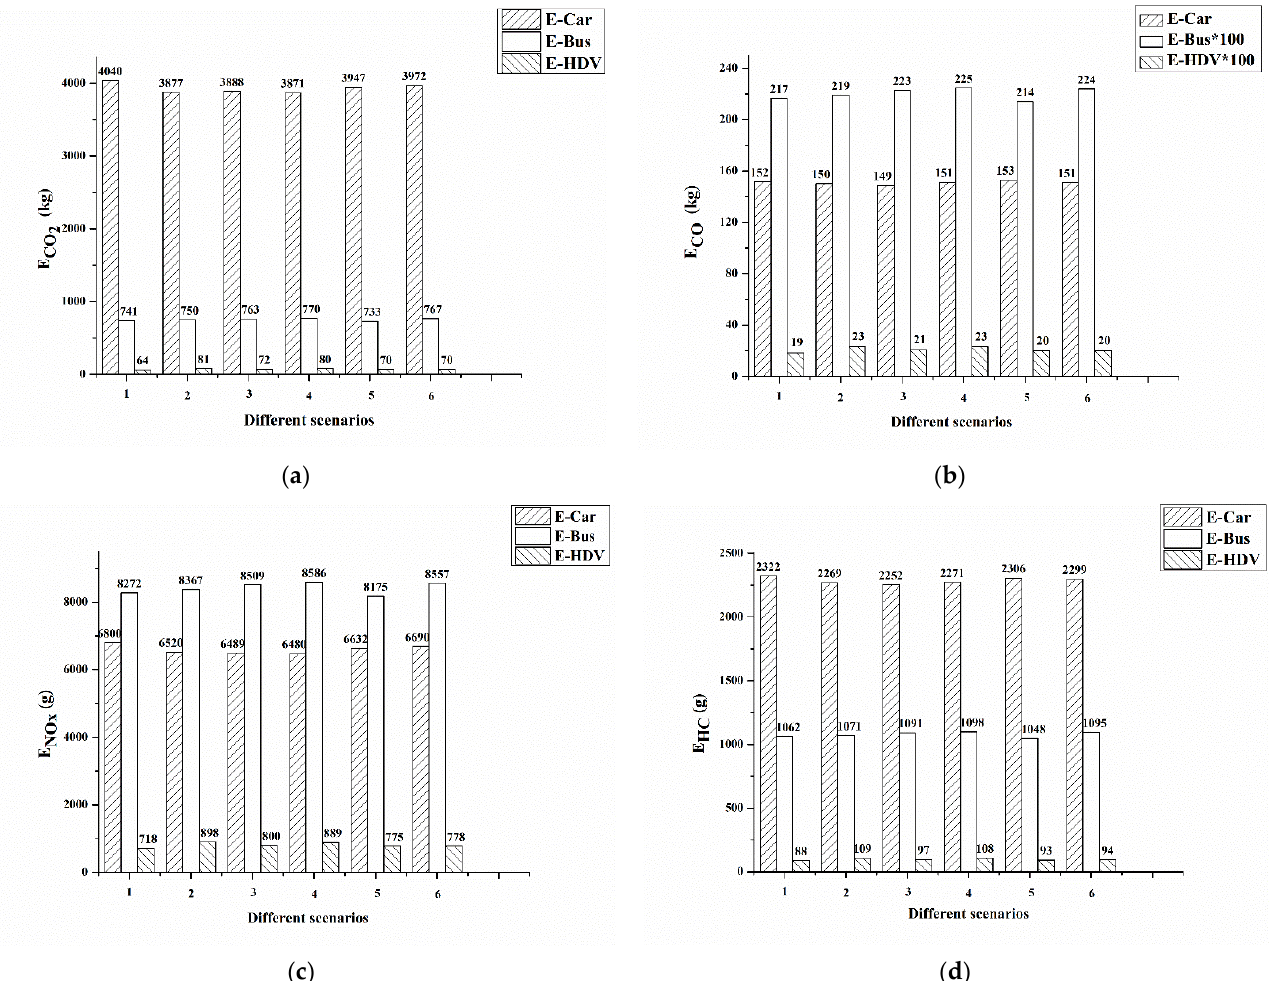
Figure 6. Total CO 2 , CO, NO X , and HC emissions for light-duty gasoline cars, diesel buses, and other HDVs under different scenarios: ( a ) CO 2 , ( b ) CO, ( c ) NO X , and ( d ) HC. Note: E-Car, E-bus, and E-HDV denote the total emissions of light-duty gasoline cars, diesel buses, and other HDVs, respectively.